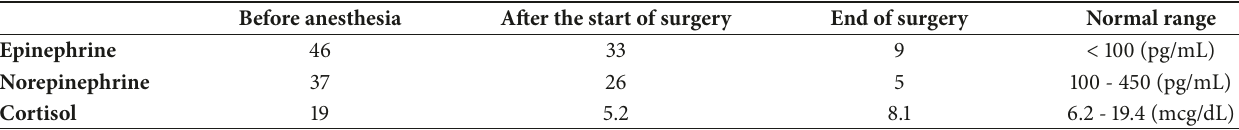
Table 1: Levels of catecholamine fractions and